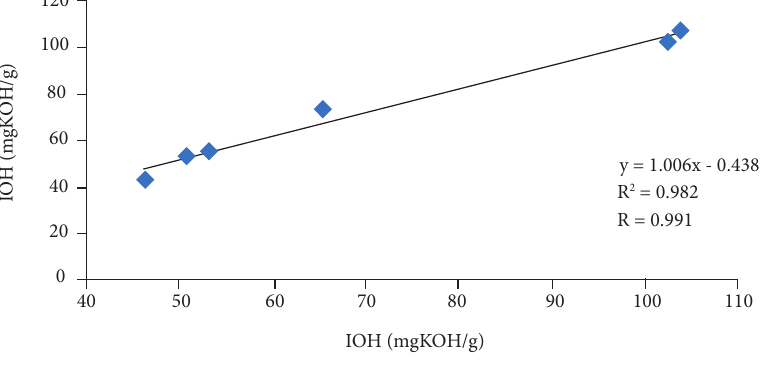
Figure 4. IOH (from supplier, by potentiometry) versus IOH by wet chemistry method (acetylation), for the surfactants studied.